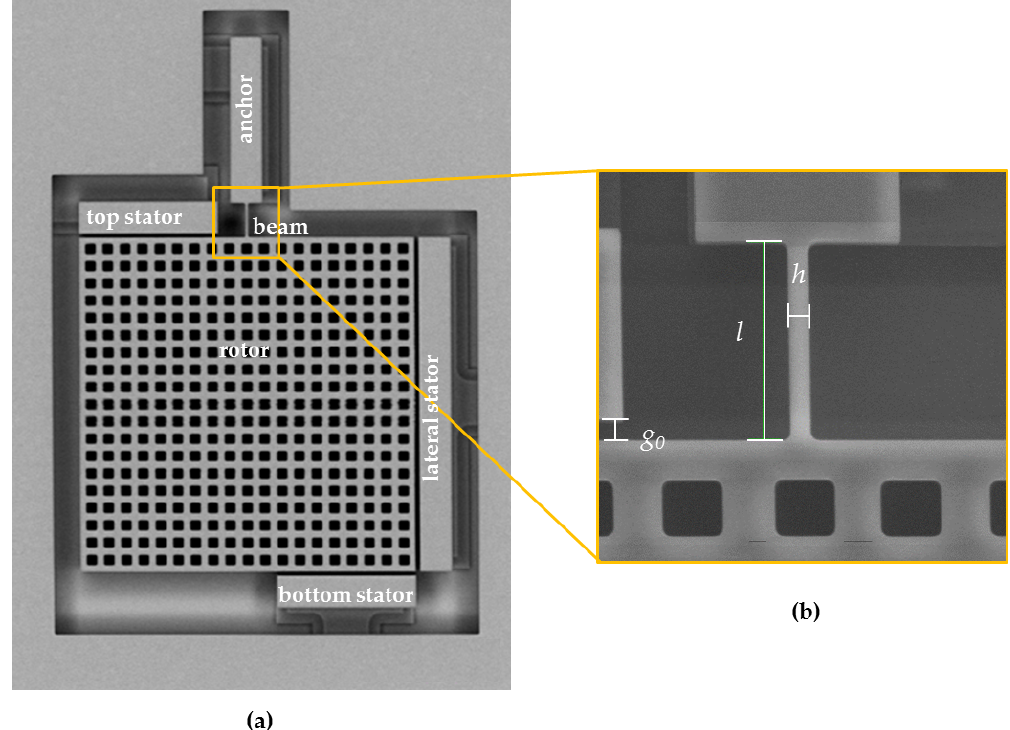
Figure 1. ( a ) SEM picture of the test device and ( b ) detail of the cantilever beam